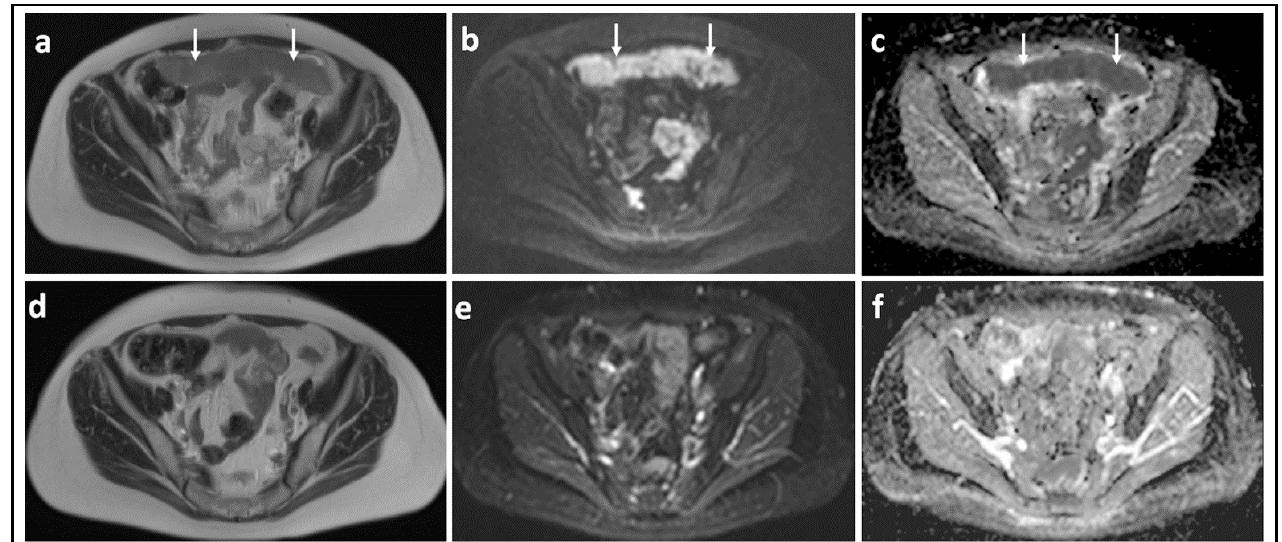
Figure 4. Omental cake showing marked response to chemotherapy: T2-W image ( a ) and corre- sponding b = 900 s/mm 2 DW-MRI ( b ) and ADC map ( c ) through the mid-pelvis in a patient with high grade serous ovarian cancer before treatment shows a large omental cake in the anterior pelvis. It is recognized by its homogenous solid appearance and marked diffusion restriction (arrows). Corresponding slices of T2-W ( d ), b = 900 s/mm 2 DW-MRI ( e ) and ADC map ( f ) after three cycles of platinum-based chemotherapy illustrate that the omental cake is no longer identifiable.